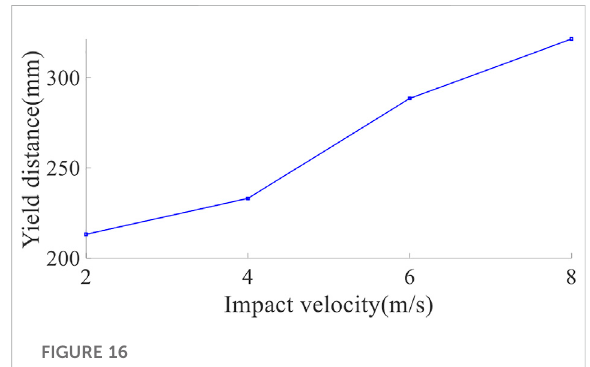
FIGURE 14 Anchor force-time curve.